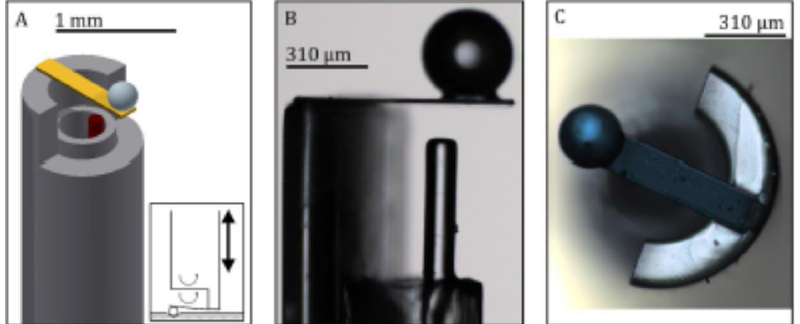
Figure 12. ( A ) Schematic of the force probe. The external capillary has a diameter of 1 mm and wall thickness of 0.21 mm, and the internal capillary, which hosts the optical fiber, has a diameter of 0.55 mm and a wall thickness of 0.075 mm. The inset shows a schematic diagram of the indentation procedure. ( B ) Microscope image of the probe showing the interferometric cavity. ( C ) Top view of the